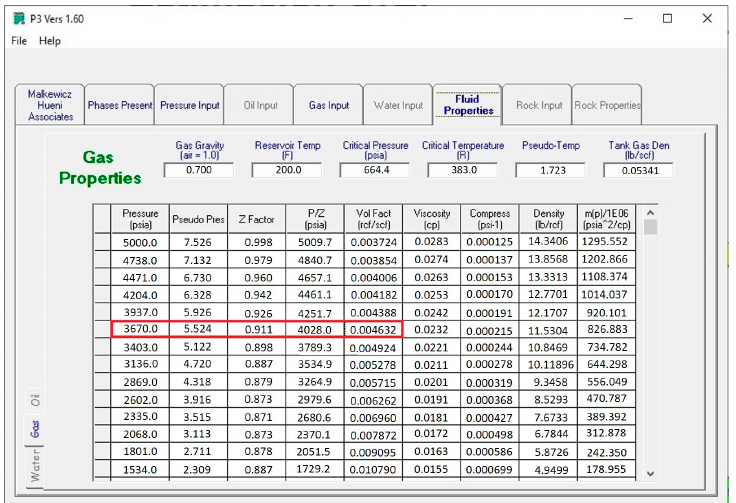
Figure 5. MHA-P3 software results for Bgi [35].